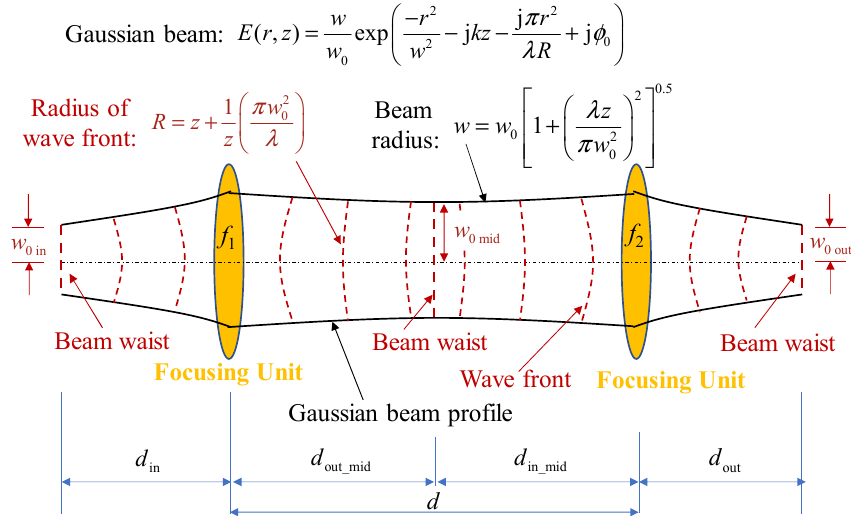
Figure 2. The propagation of a Gaussian beam through free space and the refocusing effect by focusing units.